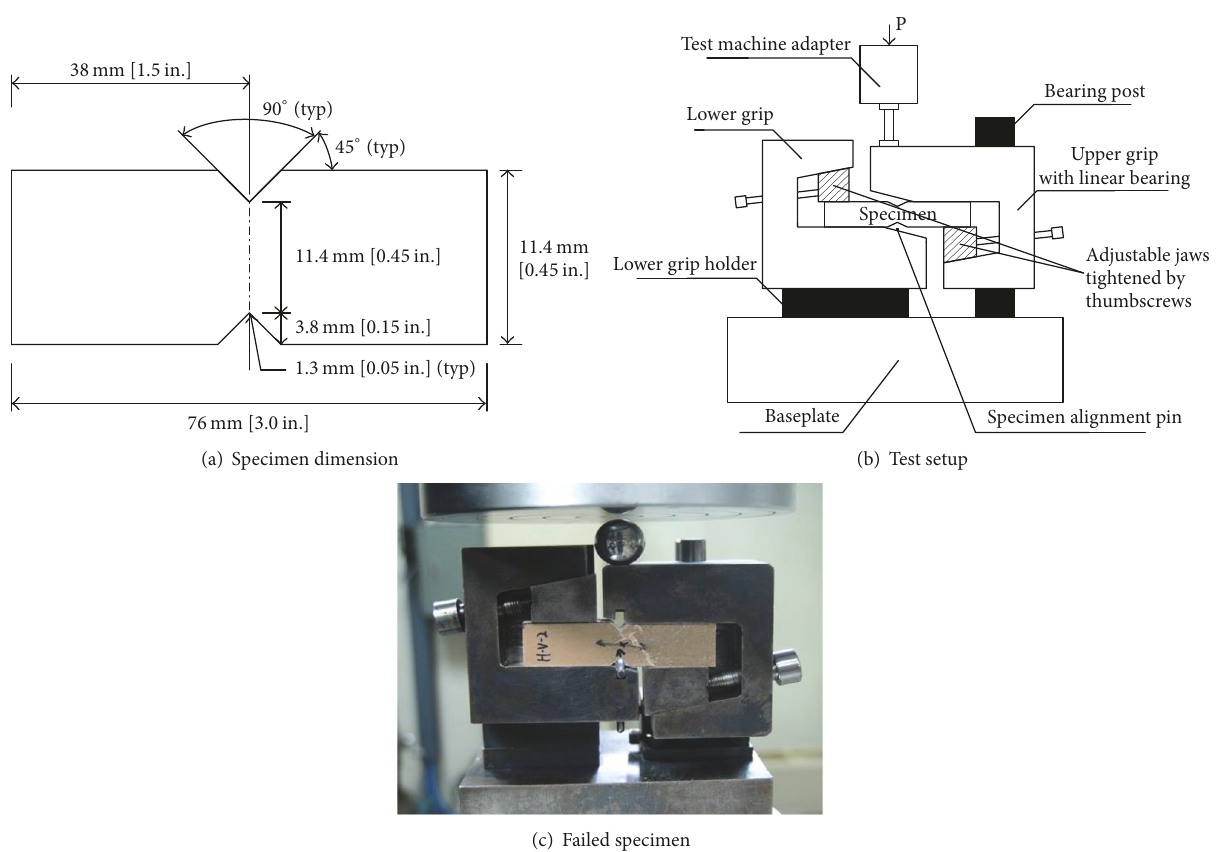
Figure 5: Shear test specimen and test